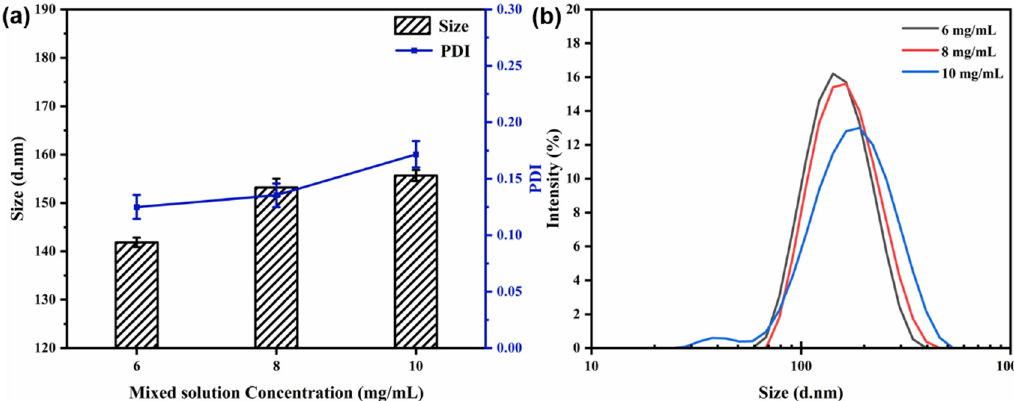
Figure 6. Effect of mixed solution concentration on particle size and PDI ( a ) and size distribution ( b ) of nanocapsules.